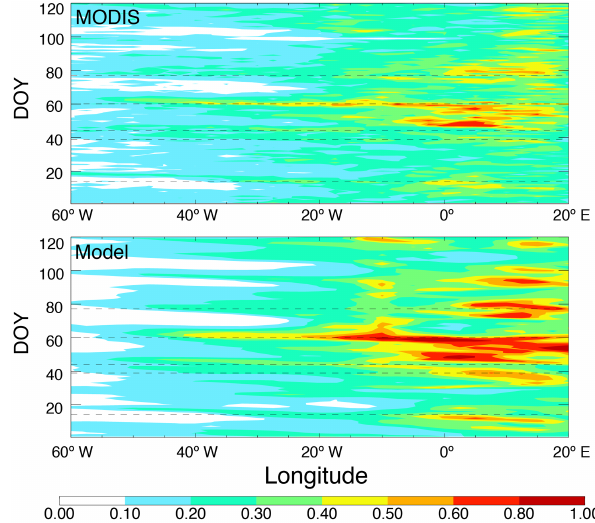
Figure 6. Daily distribution of latitudinally averaged AOD at 550nm from MODIS and model over the rectangle region between 60 ◦ W–20 ◦ E and 5 ◦ S–25 ◦ N from January–April 2014. The y axis is the day of year (DOY), starting with day 1 on 1 January 2014. Dashed lines indicate the starting dates of five transatlantic trans- port events from the east of the Atlantic (20 ◦